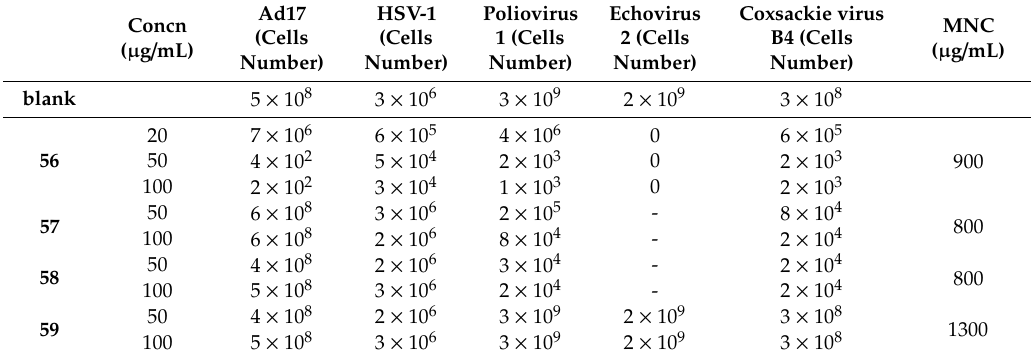
Table 7. Antiviral evaluation and in vitro cytotoxicity of compounds 56 – 59 (adapted from [102]). Concn